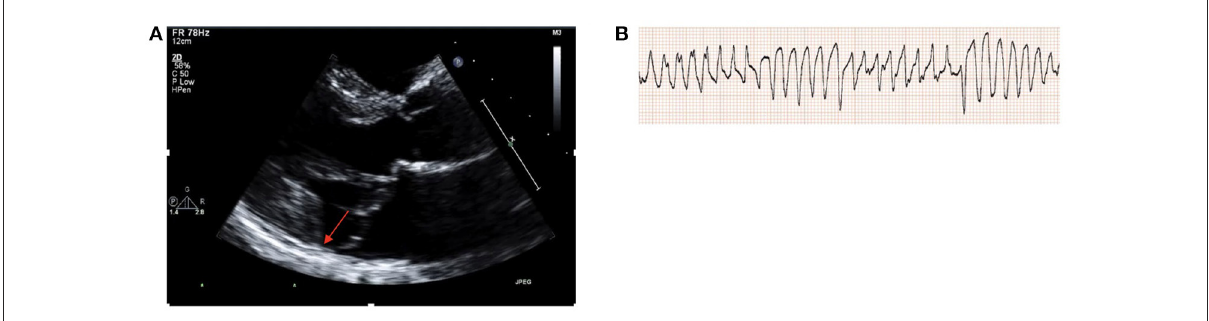
FIGURE1 (A) TTE parasternal long axis demonstrating bileaflet MV prolapse and MAD (red arrow). (B) Induction of polymorphic ventricular tachycardia during electrophysiology